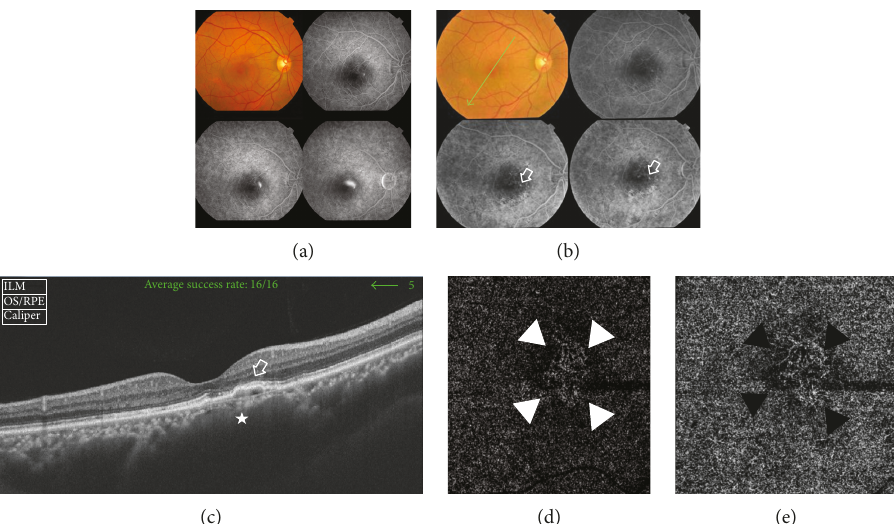
Figure 1: (a) The colored photo and FFA of the right eye of a 52-year-old male during acute CSCR. The macular area shows neurosensory detachment, measuring approximately 3 DD. Corresponding FFA shows a typical smoke-stack leaking pattern. (b) The colored photo and FFA of the same eye 2 years later. The posterior pole shows minimal retinal pigment disturbance in the inferior portion of the macular area along with subretinal deposits. On FFA, the old site of acute leakage demonstrates early pinpoint hyper fl uorescence with increasing intensity through late frames suggestive of chronic point of leakage (open arrow). The area of pigment epitheliopathy seen in the colored photo shows hyper fl uorescence due to window defect. (c) The corresponding SS-OCT image in a radial scan mode shows shallow PED with surface undulations and hyperre fl ective sub-RPE deposits (open arrow). There is associated disruption of ELM and IS/OS layers in the vicinity of the PED. Note the generalized dilatation of the choroidal vessels that is most marked in the area beneath the PED (star). Subfoveal choroidal thickness is 737 μ . (d) The en face SS-OCTA image of the same eye taken at the level of the outer retina in a 6mm × 6mm fi eld. Note the hyperintense signal caused by increased blood fl ow within the vascular network of tiny interlacing capillaries (white arrow heads). The neovascular complex is surrounded by a hypointense hollow zone intervening between the lesion and the surrounding normal outer retina that generates a hypointense signal due to the absence of blood fl ow and is displayed as a dark-grey background. (e) The en face SS-OCTA image of the same lesion at the level of the choriocapillaris (black arrow